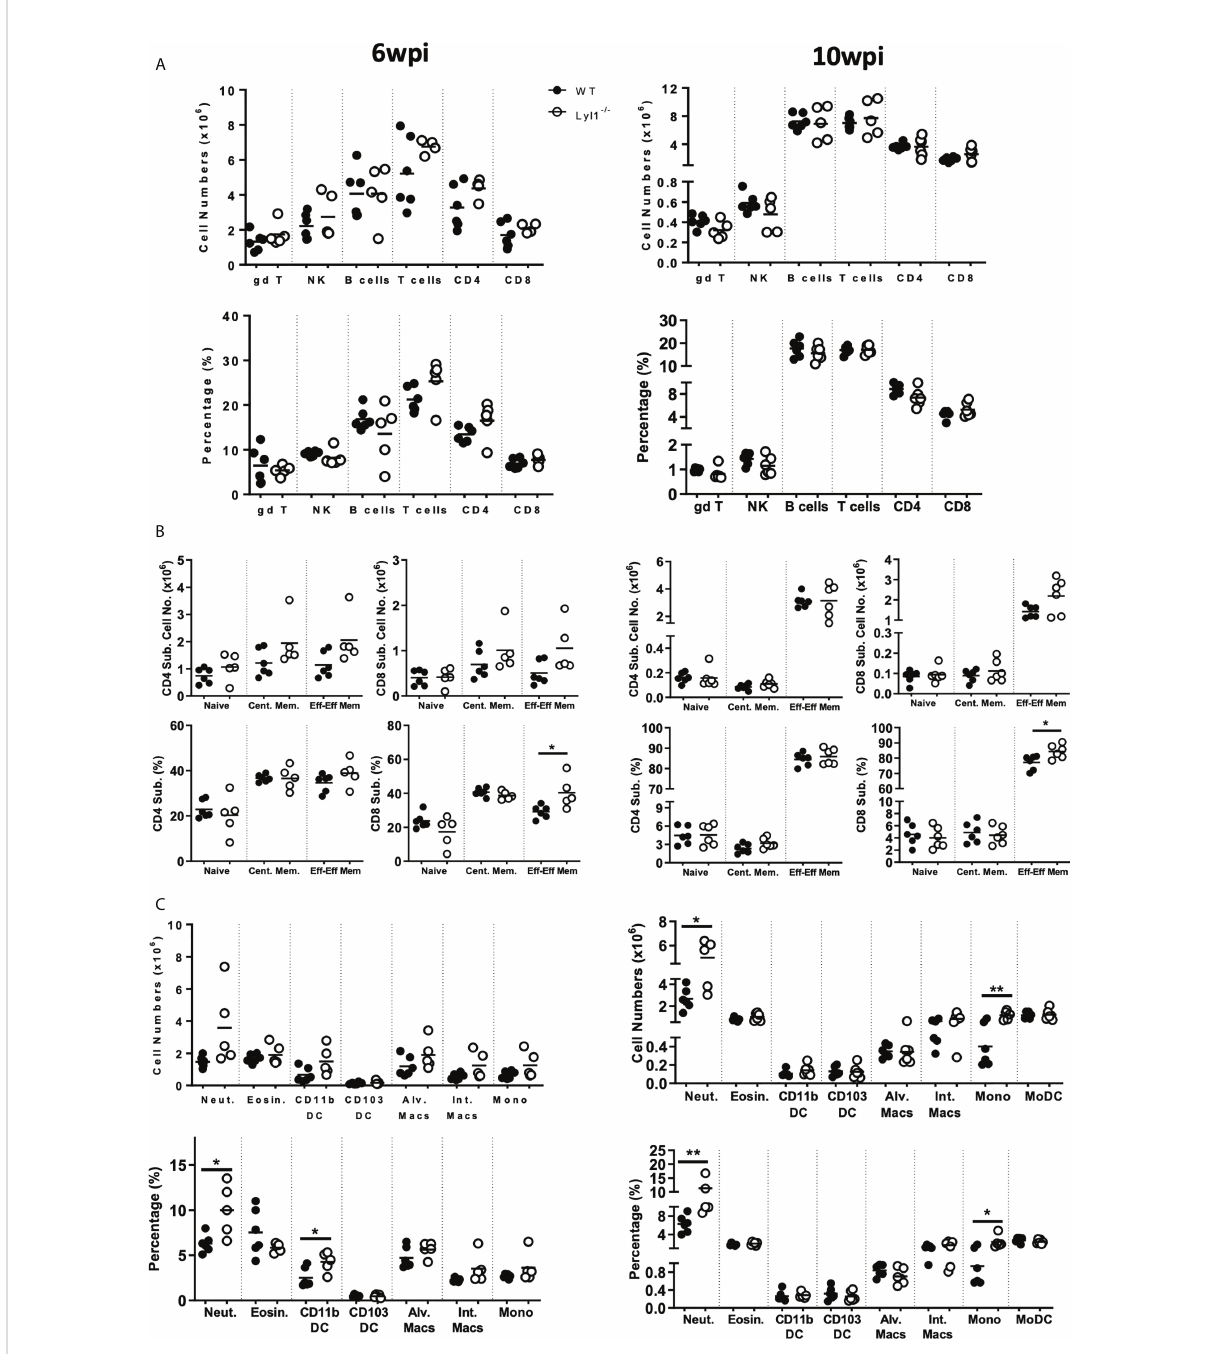
FIGURE 5 Lyl1-deletion enhances lung neutrophil and monocyte recruitment in response to chronic hypervirulent Mtb infection in vivo . (A-C) Littermate control (WT) and Lyl1 -/- mice were infected with ~100 CFU/mouse intranasally with Mtb HN878 (n = 5 mice/group) and sacri fi ced at either 6- or 10-weeks post infection. Using fl ow cytometry, single cell suspension of lung tissue was analyzed for (A, B) lymphoid and (C) myeloid total cell numbers and percentages of live cells. Naïve, central memory and effector/effector memory percentages are presented as ratio in the parent CD4 or CD8 population. Surface markers of the different cell populations are as follows (according to the gating strategy Figures S5-10): gamma delta T-cells (gd T) = CD3 + gdTCR + ; NK cells = NK1.1 + CD3 - ; B-cells = CD19 + CD3 - ; T-cells = CD3 + CD19 - ; CD4 + T-cells = CD3 + CD4 + ; CD8 + T- cells = CD3 + CD8 +; Neutrophils (Neut.) = Ly6G + CD11b + ; Eosinophils (Eosin.) = SiglecF + CD11b + CD64 - ; CD11b + DC = CD11c + MHCII + CD11b + CD64 - ; CD103 + DC = CD11c + MHCII + CD103 + CD64 - ; Alveolar Macrophages (Alv. Macs) = CD64 + MerTK + SiglecF + CD11c + ; Interstitial Macrophages (Int. Macs) = CD64 + MerTK + SiglecF - CD11b + CD11c - ; Monocytes (Mono) = Ly6C + CD11b + CD64 - ; Monocyte-derived DC (MoDC) = CD64 + CD11b + CD11c + . Line denotes Mean. Data shown is representative of 2-3 independent experiments. Unpaired student t-test analysis at *p < 0.05, **p < 0.01 to determine signi fi